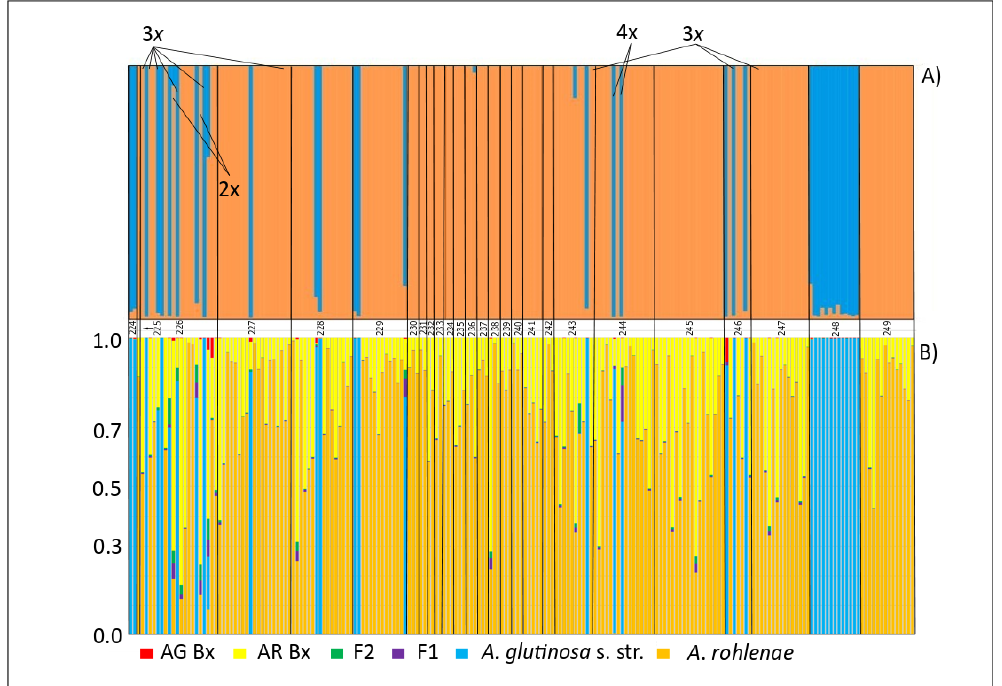
Figure 4. ( A ) Percentage assignment of Alnus individuals (represented by vertical bars) to each of the clusters determined (represented by different colours) inferred by STRUCTURE. Site codes (see Supplementary Table S1) indicate the geographical location of the populations along the x-axis. Blue colour represents the majority of the diploid and triploid individuals, and orange colour, the majority of the tetraploid individuals. ( B ) Hybrid class assignments, F1 hybrids (F1), F2 hybrids (F2), F1 backcrosses to A. glutinosa s. str . (AG Bx) and F1 backcrosses to A. rohlenae (AR Bx)